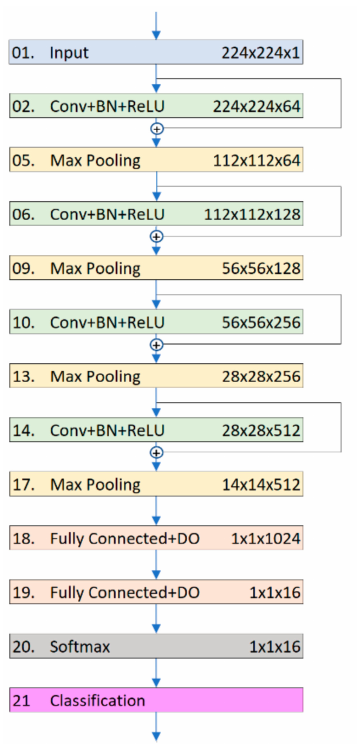
Figure 4. Residual CNN6